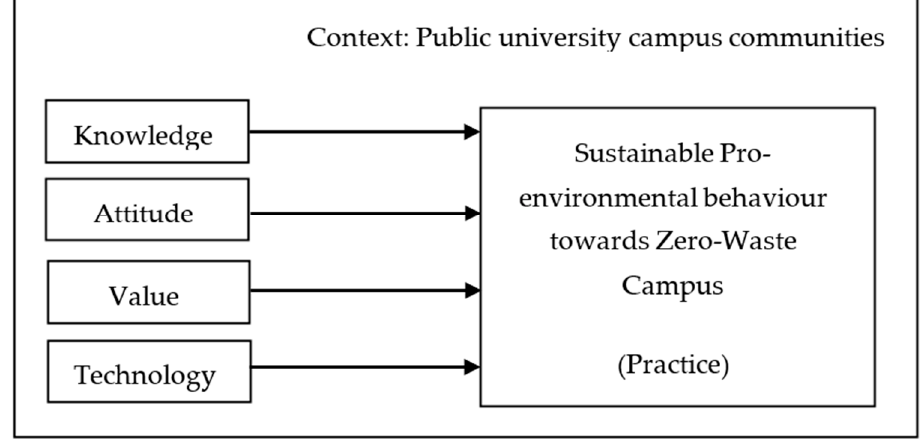
Figure 2. Conceptual framework.